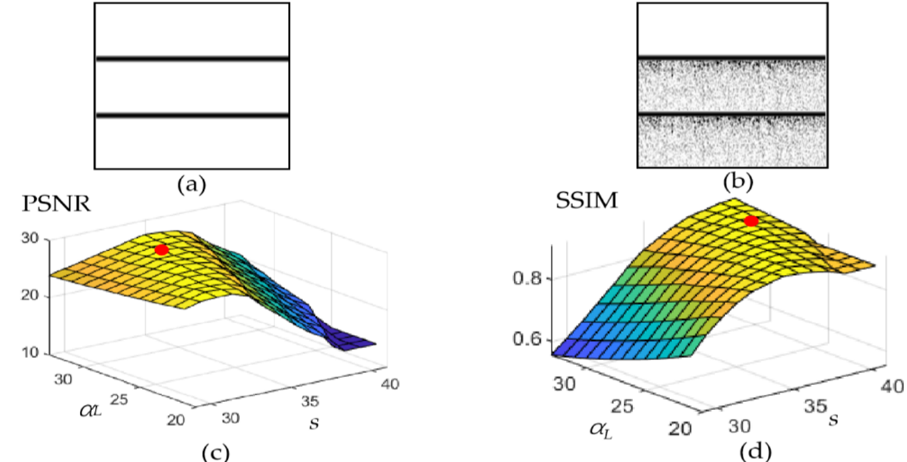
Figure 5. Illustration of parameter settings. ( a ) and ( b ) show the first synthetic clean SBP image and the polluted SBP image, respectively. ( c ) shows the peak signal-to-noise ratio (PSNR) surface and the red point has the highest value, ( d ) shows the structural similarity index (SSIM) surface obtained similarly to the PSNR surface and the red point has the highest value.